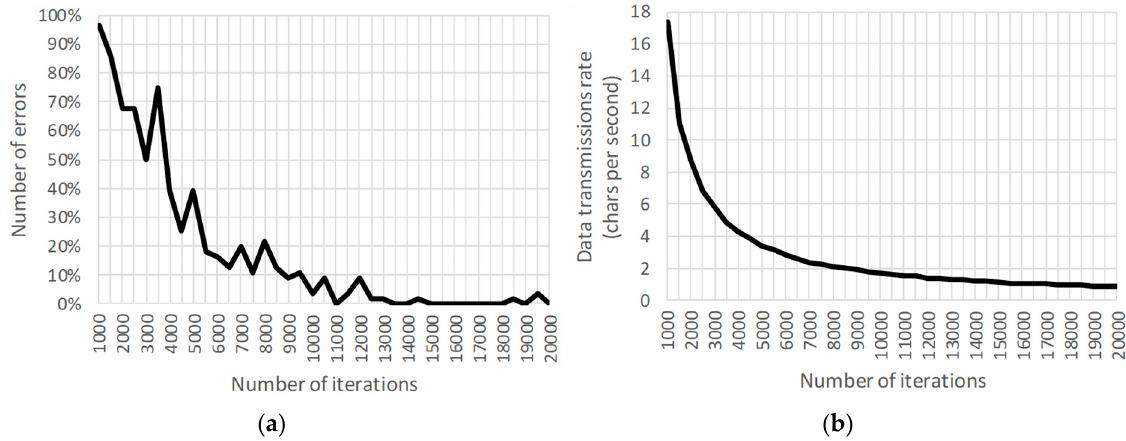
Figure 21. Statistical analysis after message delivery. ( a ) Error rate vs. number of transmission repetitions; and ( b ) Transmission speed vs. number of transmission repetitions.